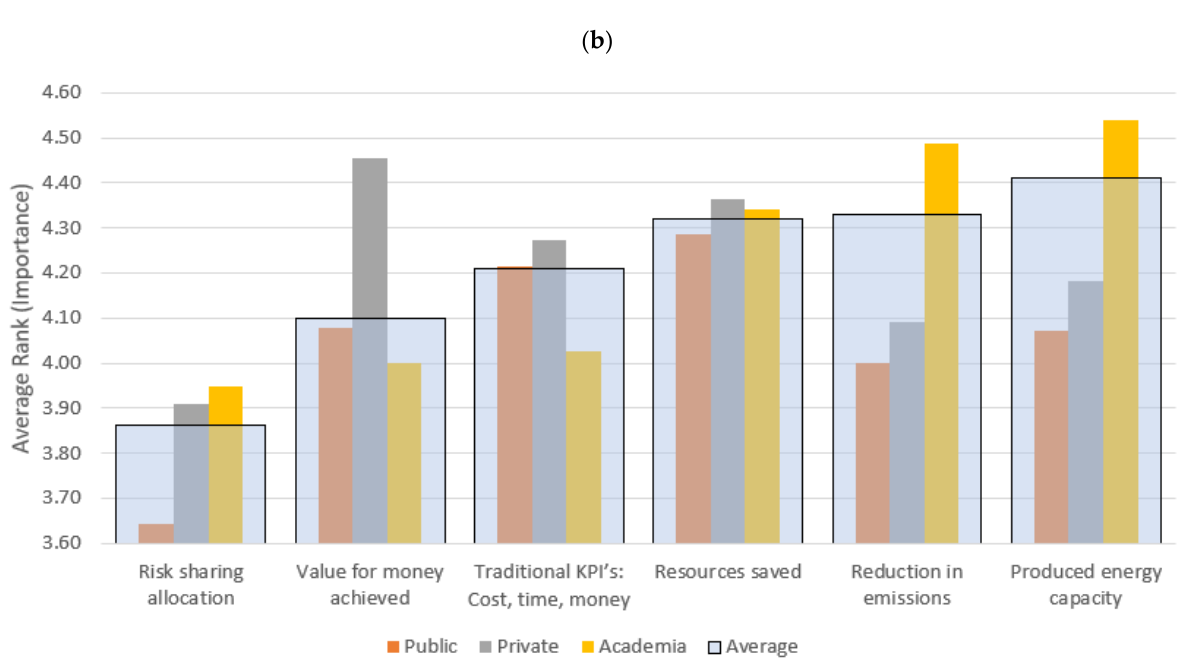
Figure 3. ( a ) Key success factors and ( b ) key success indicators of renewable-energy PPPs as per- ceived by the different